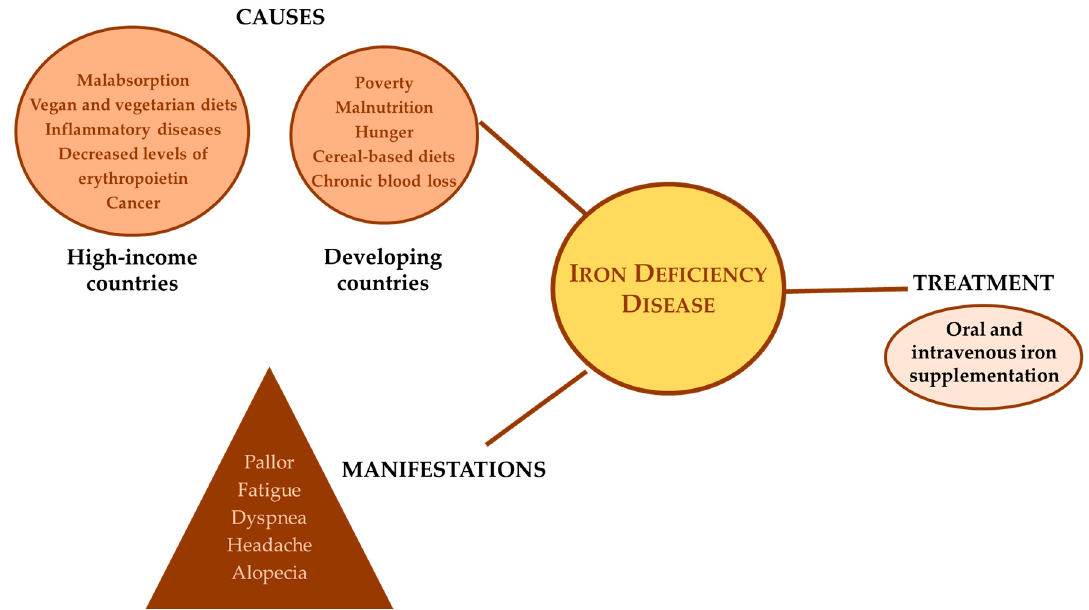
Figure 1. Main causes, manifestations, and current treatments for iron-deficiency in humans.